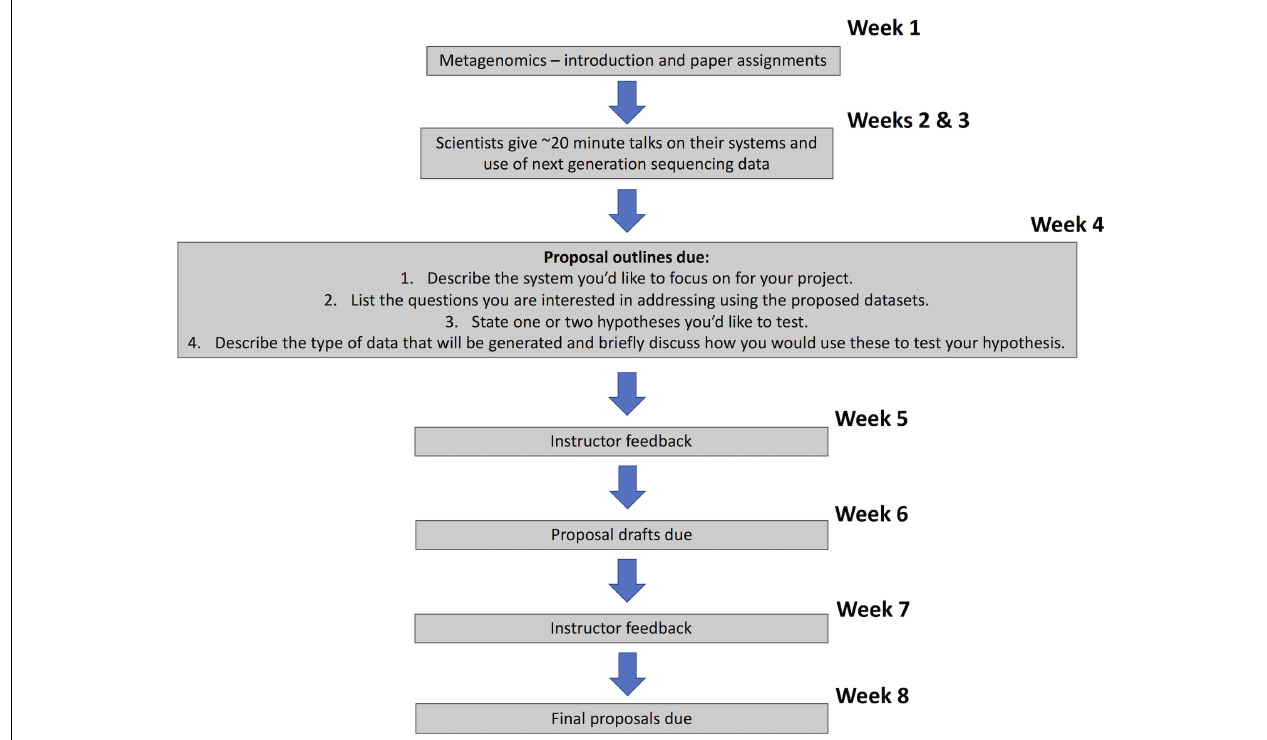
FIGURE 2 | Timeline of the molecular ecology lab